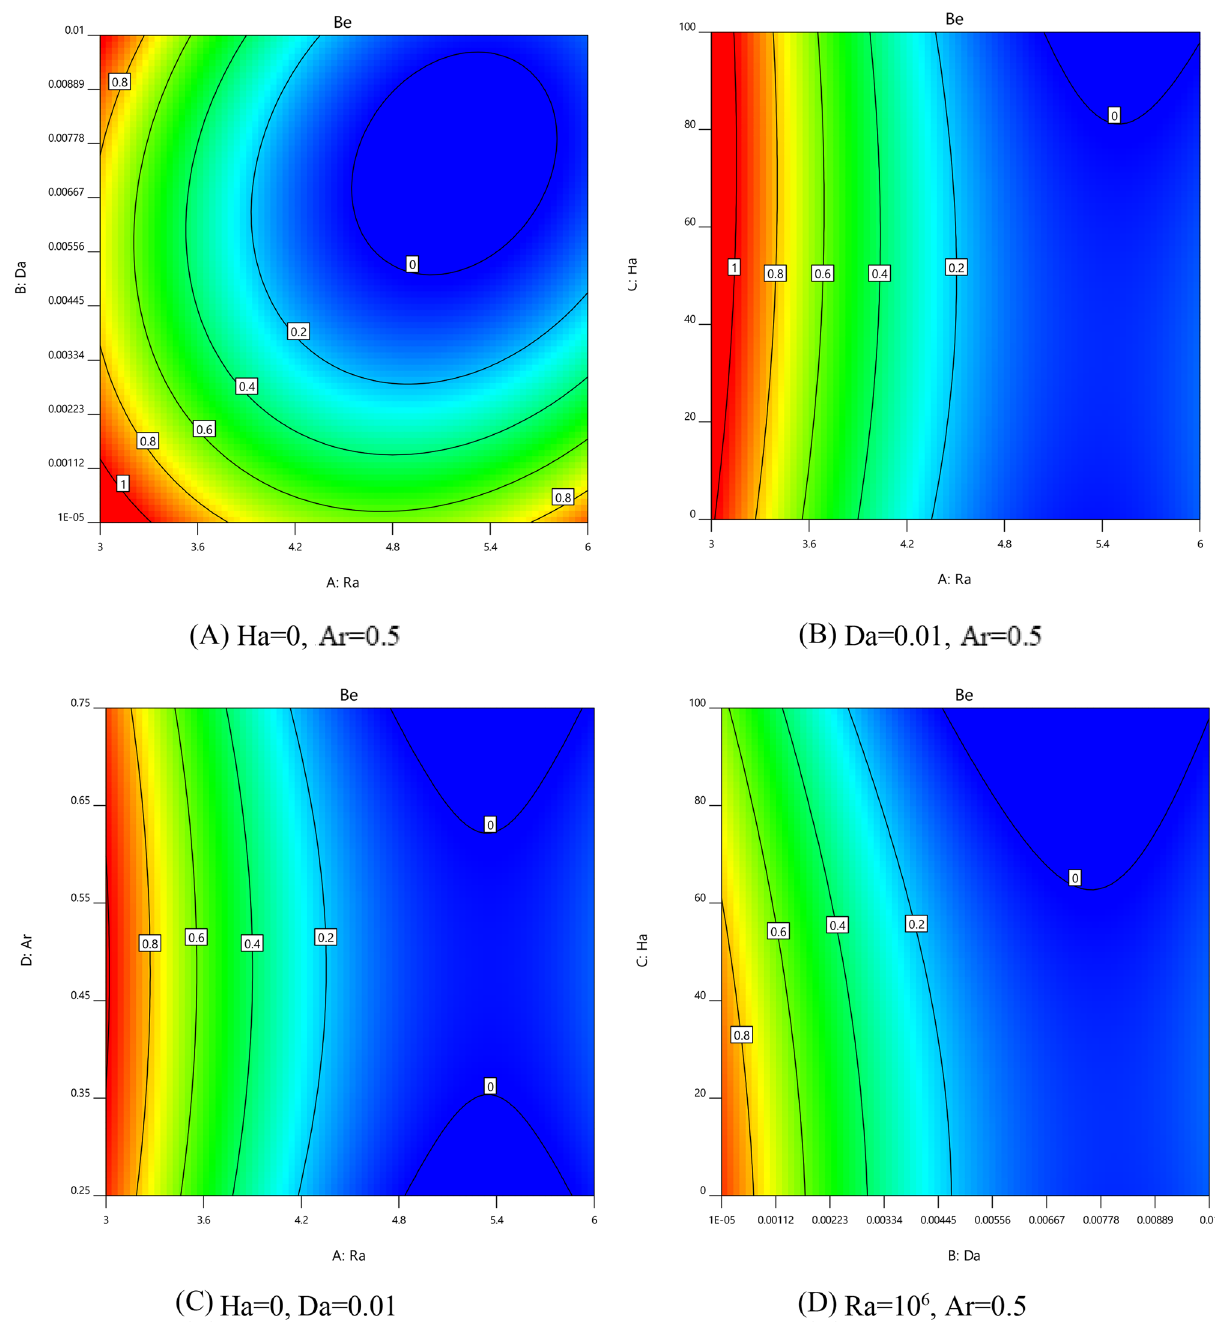
Figure 8. The variation Bejan number with various